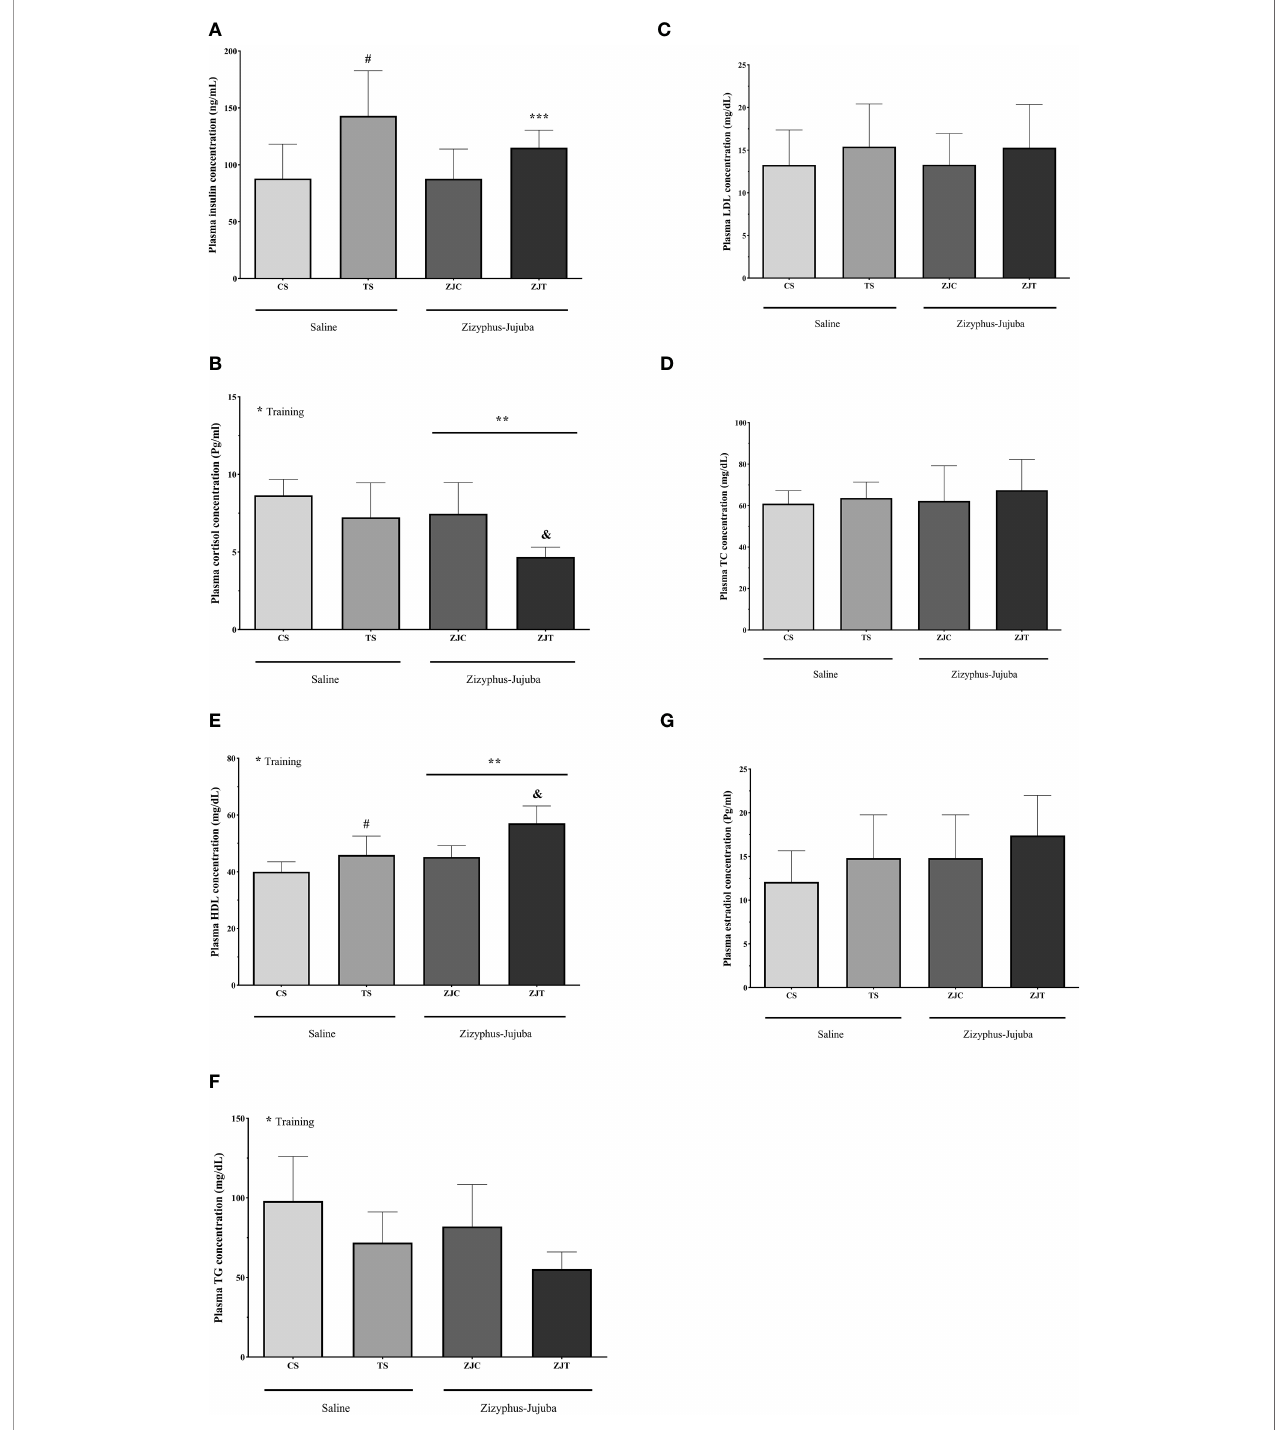
FIGURE 6 | Plasma insulin (ng/ml) (A) cortisol (Pg/ml) (B) , HDL (mg/dl) (C) , TG (mg/dl) (D) LDL (mg/dl) (E) , TC (mg/dl) (F) and estradiol (Pg/ml) (G) concentrations in Saline-Control (SC), Saline-High Intensity Training (ST), Ziziphus jujuba -Control (ZJC), and Ziziphus jujuba -High Intensity Training (ZJT) groups. Data were expressed mean ± SD, P value set at < 0.05, and 7 rats per each group. * Training main effect (P=0.002, P=0.001 and P=0.05 for cortisol, HDL and TG, respectively, ** Ziziphus jujuba main effect (P=0.005 and P=0.001 for cortisol and HDL, respectively), *** Training and Ziziphus jujuba intraction (P=0.022 for insulin), # TS than CS (P=0.02 and P=0.046 for insulin and HDL respectively), & ZJT than TS (P=0.007 and P=0.001 for cortisol and HDL,